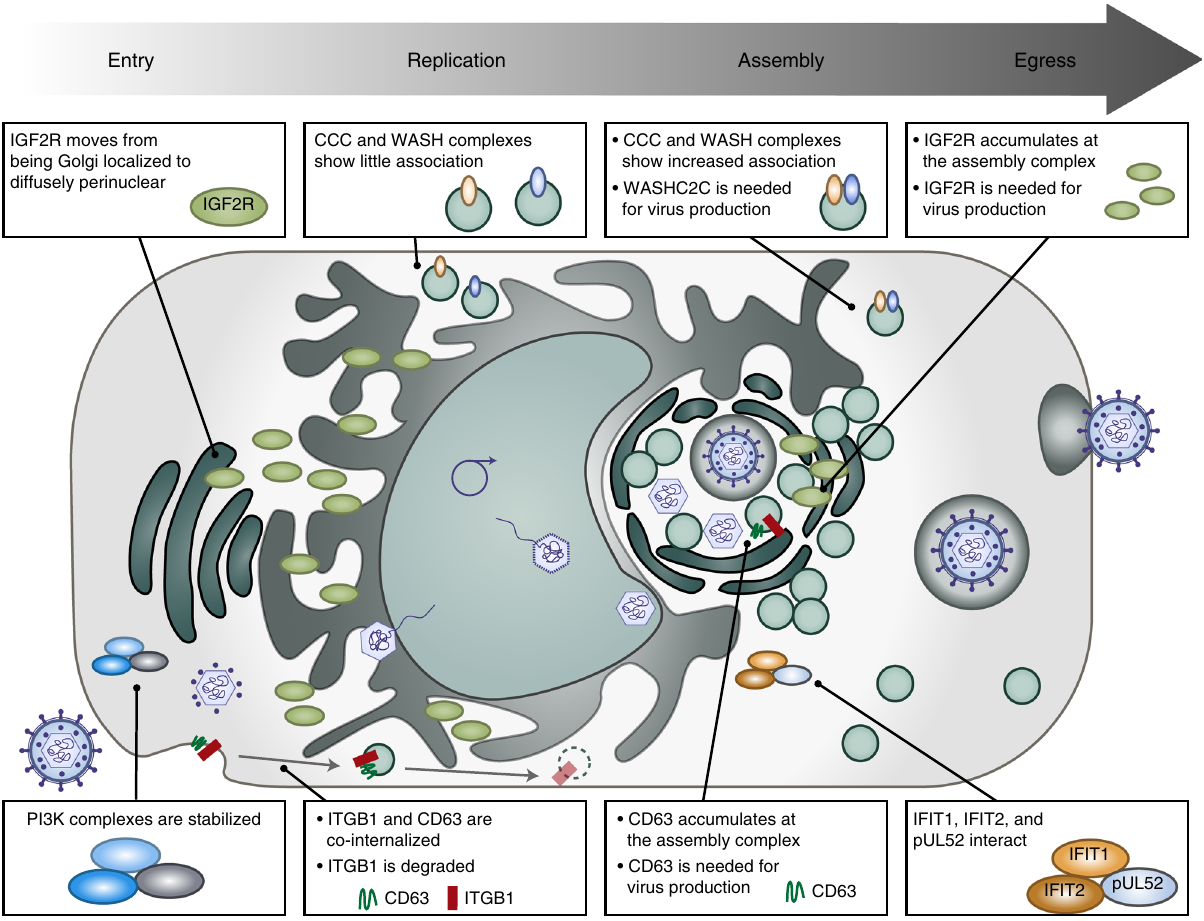
Fig. 9 Thermal shift assays uncover temporal alterations in host – host and virus – host protein associations during HCMV infection. At early stages of HCMV infection, the PI3K pathway is stabilized as the PI3K signaling axis is activated. Also early in infection, ITGB1, a receptor for HCMV, is internalized with the pro-viral tetraspanin CD63. As infection progresses, CD63 localizes to the viral assembly complex. Our study also uncovers a pro-viral role for the translocating protein IGF2R, whose localization changes from diffuse around the nucleus at early stages of HCMV infection to an accumulation at the viral assembly complex during virion maturation. Additionally, the endosomal transport complexes WASH and CCC display increased association late in infection, suggesting a pro-viral role via regulation of intracellular traf fi cking during viral assembly and egress. Finally, our study uncovers an association between the essential viral protein pUL52 and the host immune response proteins IFIT1 and IFIT2 at late stages of HCMV